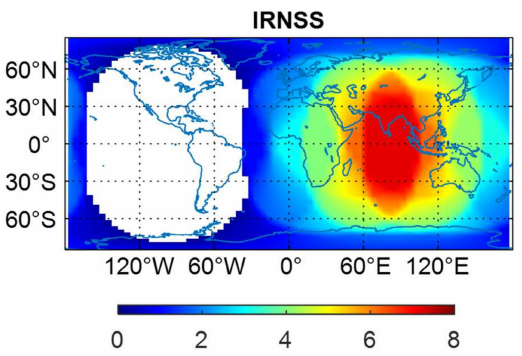
Figure 3. Average number of visible satellites for IRNSS-only